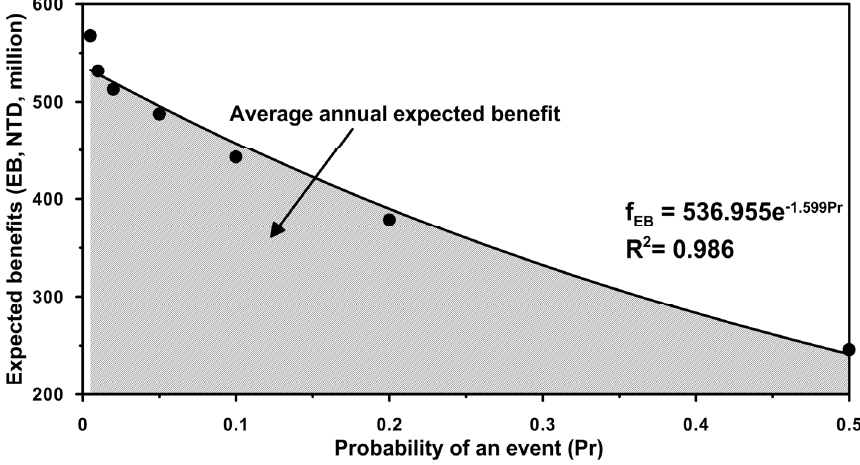
Figure 11. Expected benefit vs. probability of an event for different return